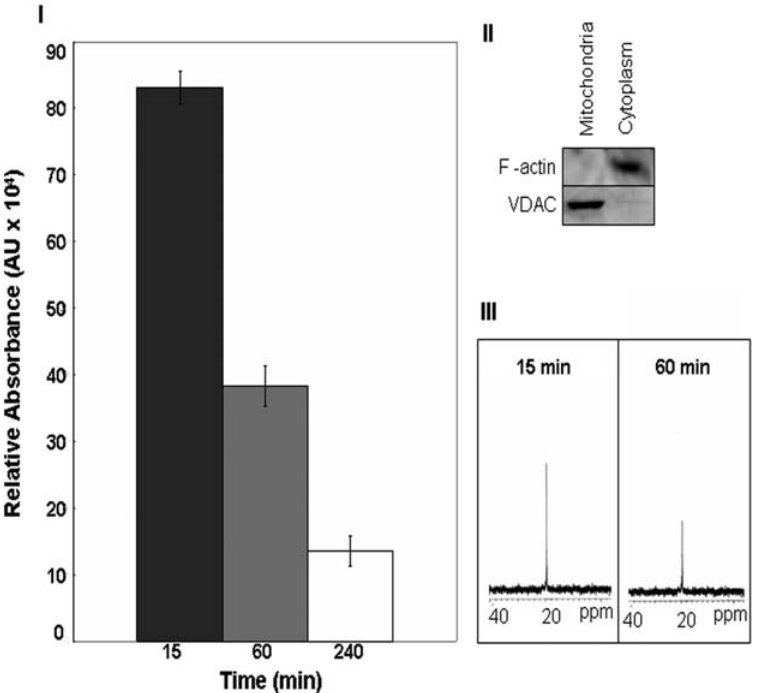
Figure 2. Lactate consumption by mitochondria derived from this astrocytic cell line. I) Mitochondria were incubated with 5mM lactate and 0.1mM NAD + . The time dependent consumption of lactate by the mitochondria was measured using HPLC. II) The purity of the mitochondrial and cytoplasmic fractions were confirmed using VDAC and F-actin respectively. III) Mitochondrial lactate consumption was confirmed using NMR spectroscopy. Data were acquired after 15min and 60min respectively. n=3, mean 6